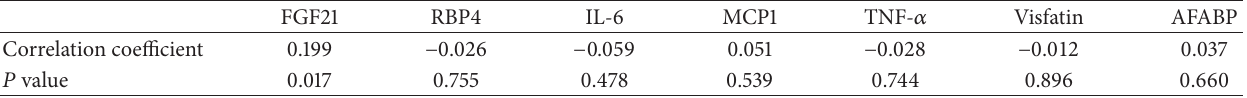
Table 7: Kendall’s tau-b correlation between circulating levels of CTRP1 and other cytokines under normal conditions. FGF21 RBP4 IL-6 MCP1 TNF- 𝛼 Visfatin AFABP Correlation coefficient 0.199 𝑃